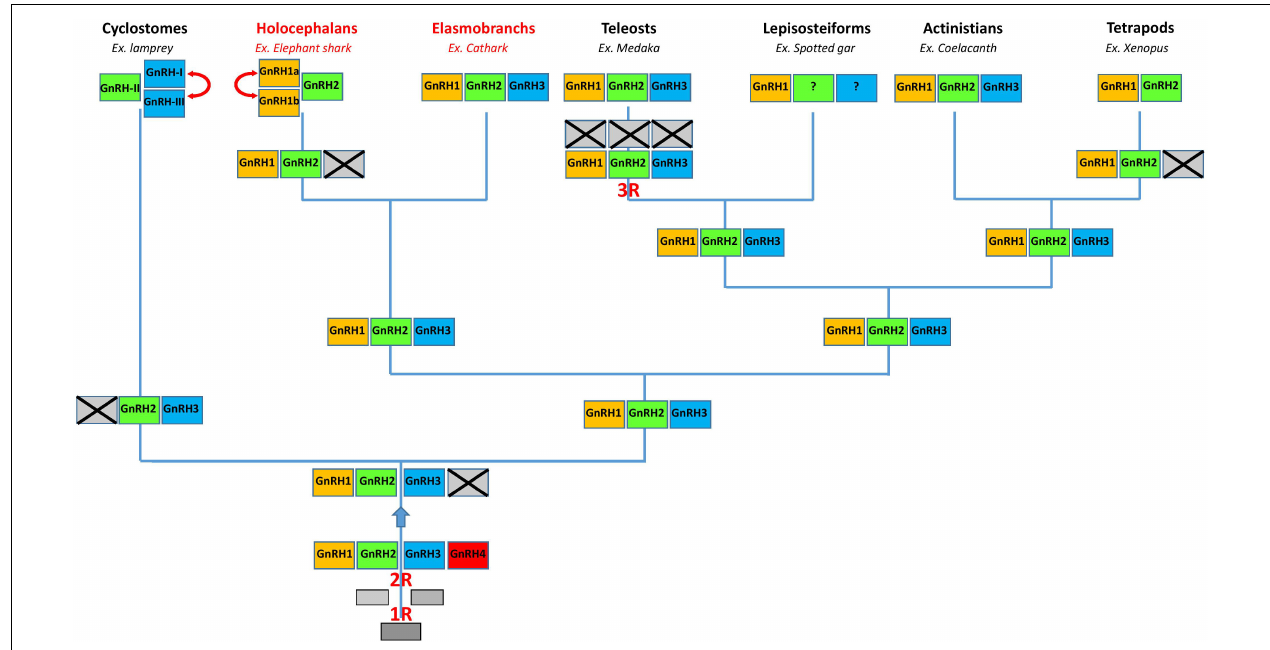
FIGURE 9 | A proposed evolutionary scheme for the evolution of the GnRH gene family in vertebrates with a special emphasis on chondrichthyan species (in red). The names of the different paralogous genes are given in the boxes. Crossed-out boxes represent lost genes. Double-headed arrows represent local duplications. R, rounds of whole genome